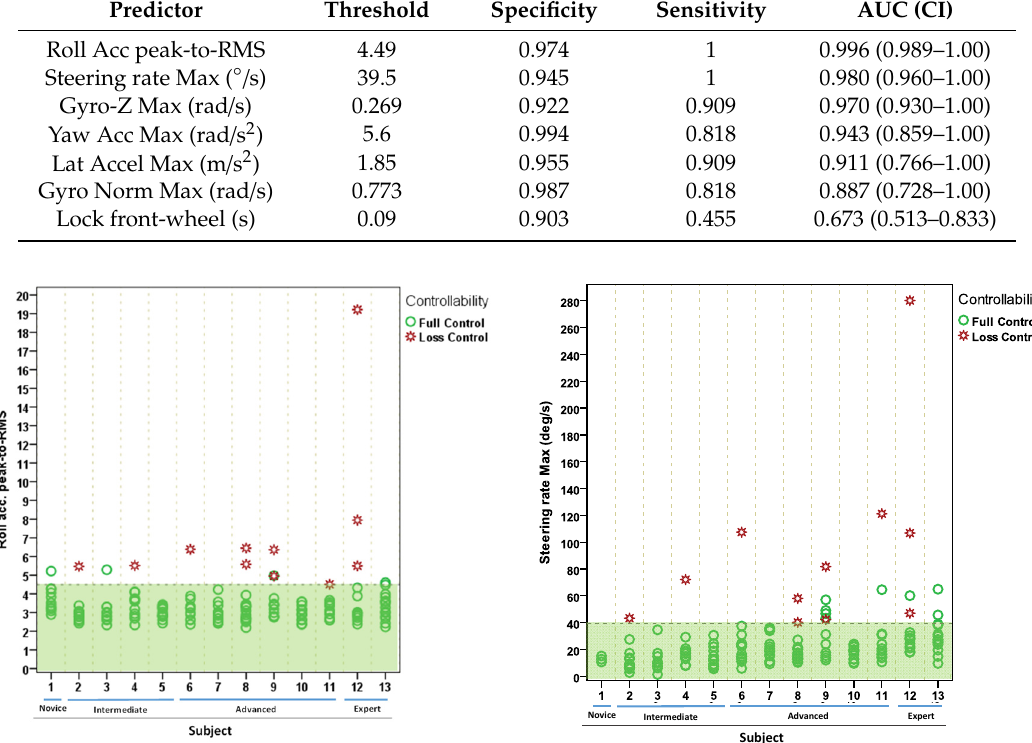
Figure 10. Scatter plot of loss of control probability by subject for the 165 braking trials for peak-to-RMS ratio of roll acceleration and “steering rate” (best decision threshold in dotted